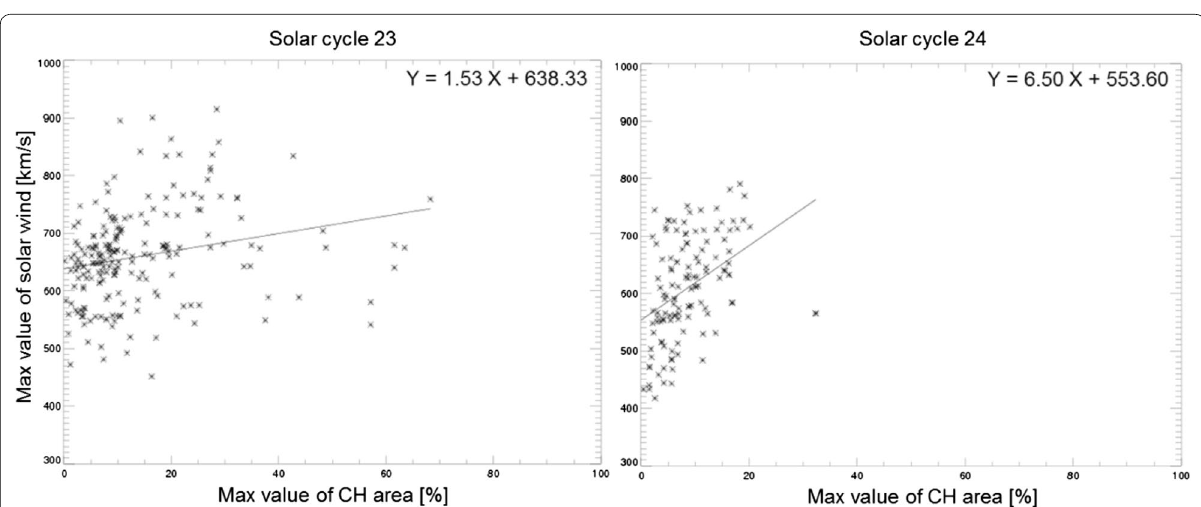
Fig. 8 The scatter plot of the maximum value of CH area and the maximum value of solar wind speed in cycles 23 and 24. The horizontal and vertical axis represents the CH area and the solar wind speed, respectively. The black line is a linear regression